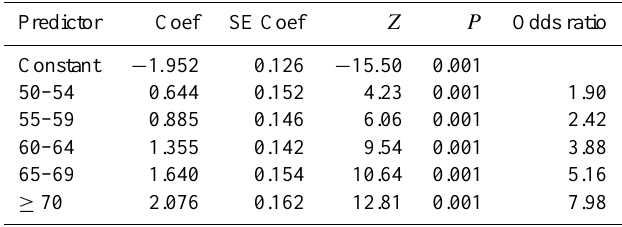
Table 4. Logistic regression model for the influence of ewe premating live weight on the multiple birth rate. ∗